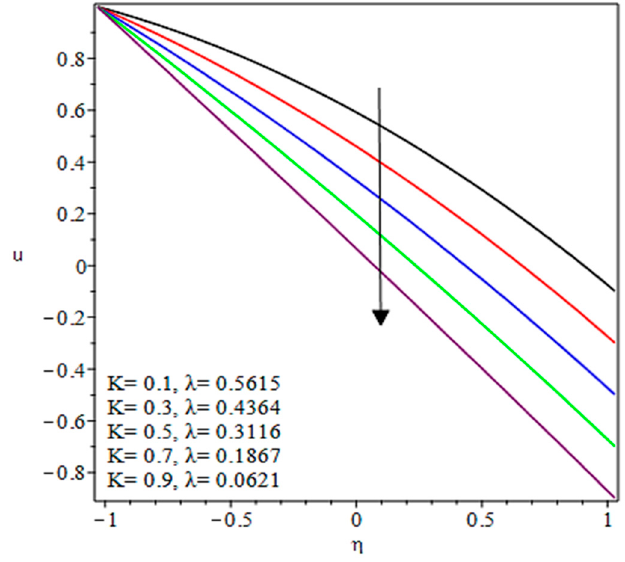
ξ= 0.25 ξ= 0.25 by fixing = 0.2 M and by fixing = 0.2 M and